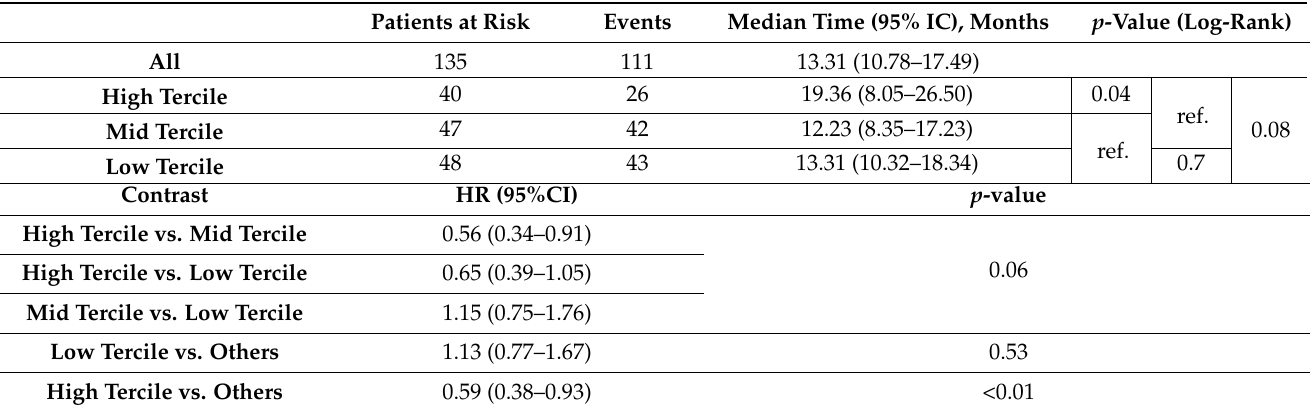
Table 4. Death risk compared by terciles independently and grouped